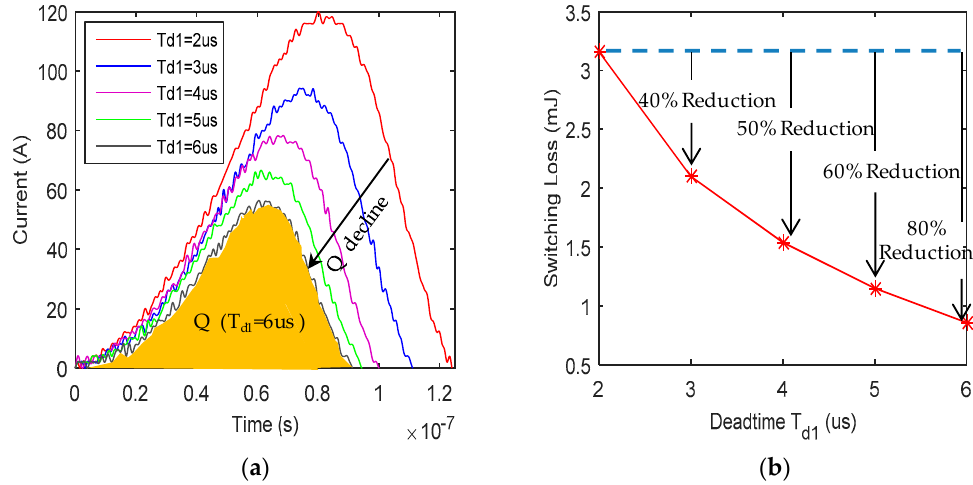
Figure 9. IGBT ZCHV turn-off current bumps and the turn-off losses with various T d1 ( a ) ZCHV turn-off the current bumps in the IGBT with various T d1 ; and, ( b ) The IGBT ZCHV turn-off losses with various T d1 .